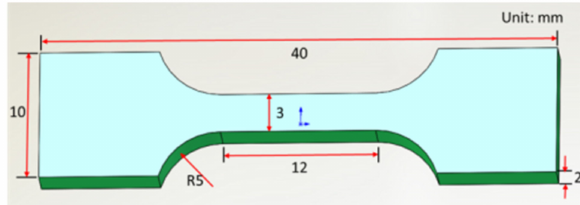
Figure 3. Dimensions of the tensile plate specimens.